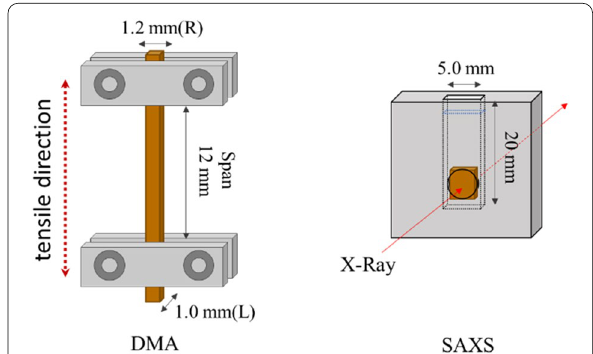
Fig. 2 The schematic diagram of measurement of dynamic mechanical analysis (DMA) and small angle X-ray scattering